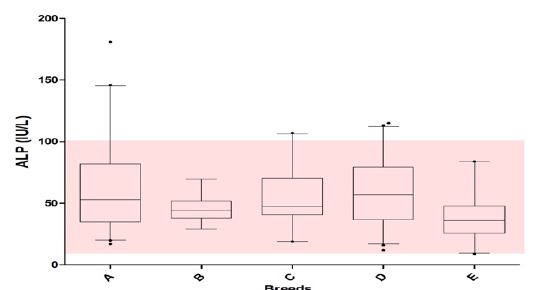
Figure 2. Biochemical results recorded in the 5 breeds of dogs included in this study (Ari é geois–A, Bleu de Gascogne–B, Bracco italiano–C, Segugio italiano–D, and Briquet Gri ff on Vandeen–E). The boxes represent the lower quartile, median, and upper quartile, and the whiskers represent the minimal and maximal values. The small points indicate outliers (i.e., values exceeding quartiles). The gray area indicates the reference intervals reported for biochemical data (claimed RIs) (Alb = albumin, TP = total protein, AST = aspartate aminotransferase, ALT = alanine aminotransferase, ALP = alkaline